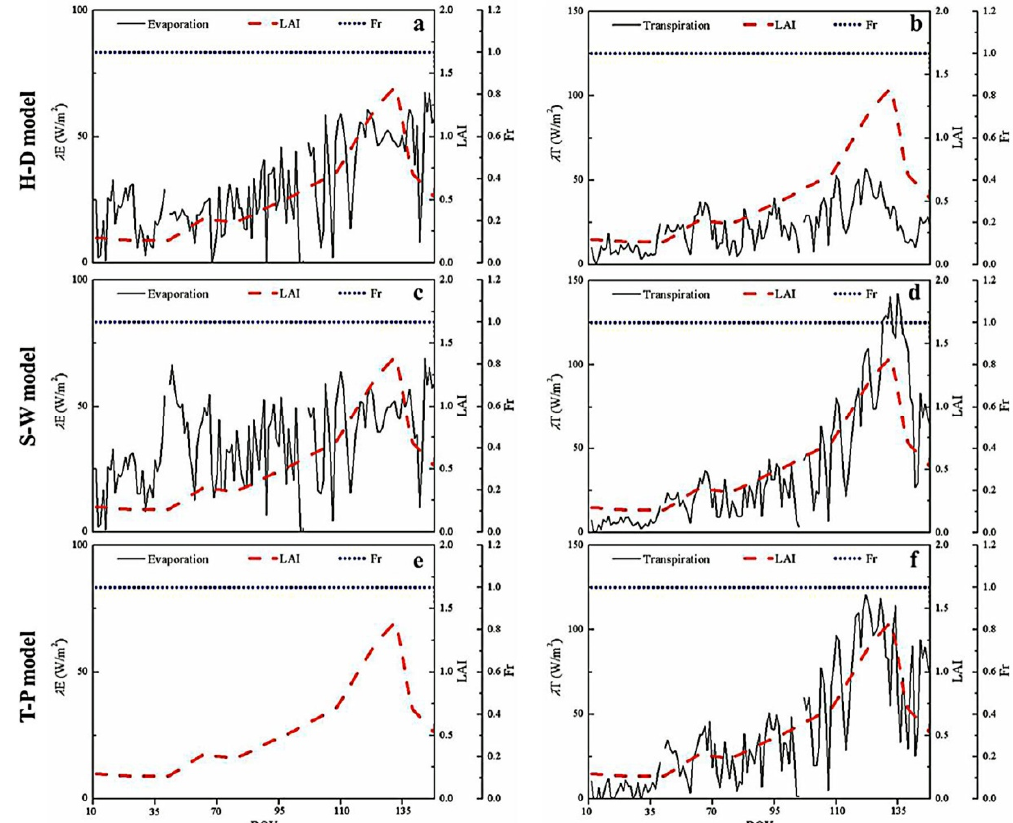
Figure 7. Variations in daily leaf area index (LAI), fractional vegetation coverage ( F r), and estimated evaporation ( λ E) ( left ) and transpiration ( λ T) ( right ) from three dual-source